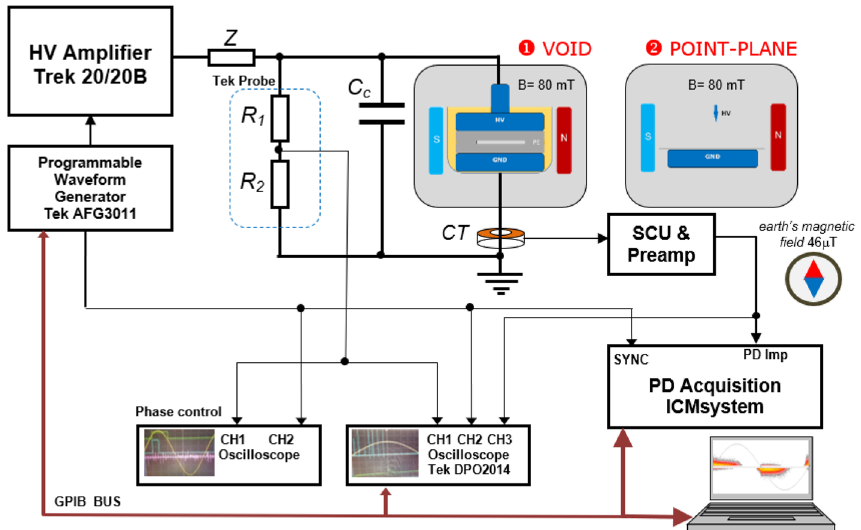
Figure 7. Instrumentation for partial discharge measurement in crossed electric and magnetic fields: ( 1) void in PE specimen; (2) point-plain corona arrangement.